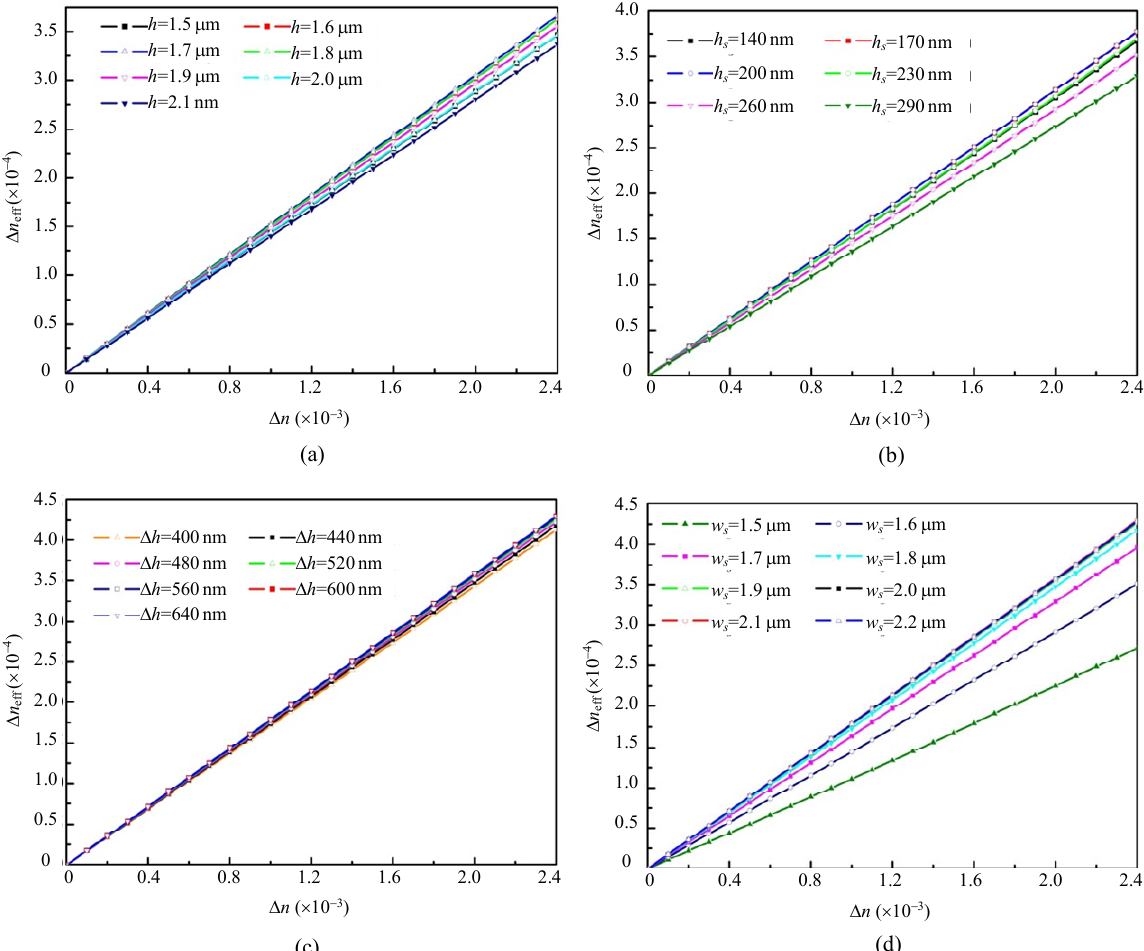
Fig. 2 Variation of Δ n eff with the cladding index varying from 1.3180 to 1.3204 for different (a) slot waveguide heights h , (b) slot heights h s , (c) height differences Δ h (= h 2  h 1 ) of the upper and the lower waveguide, and (d) waveguide widths w s